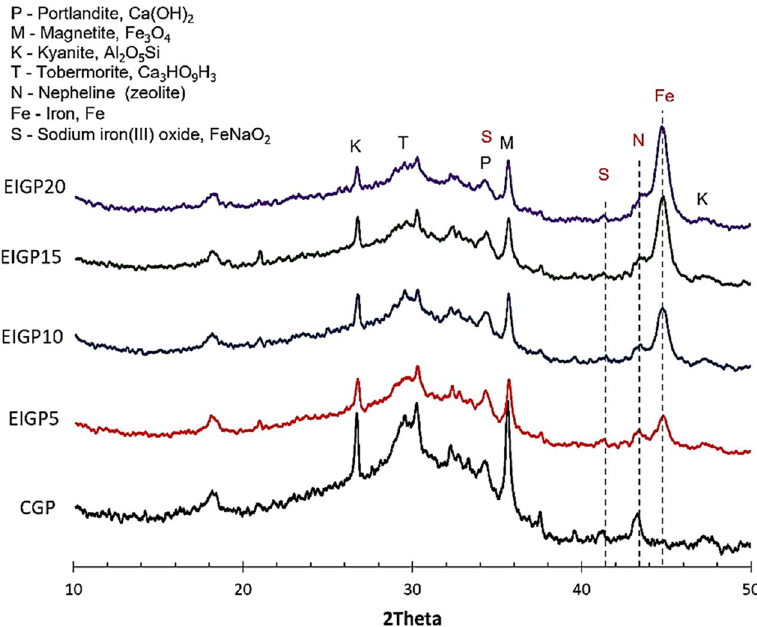
Figure 7. XRD results of EIGP